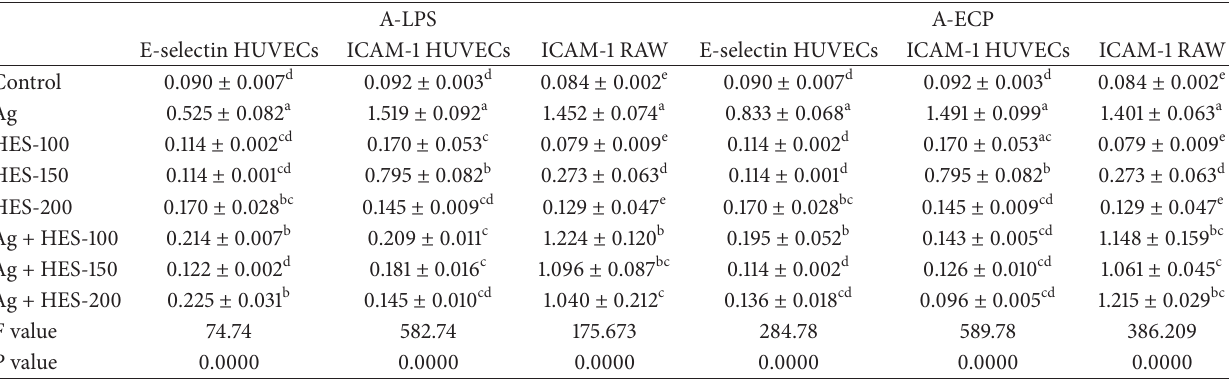
Table 1: In vitro effect of different concentrations of hesperidin on the expression of E-selectin and ICAM-1 on HUVECs and RAW cells in response to Aeromonas hydrophila antigen stimulation. Human umbilical vein endothelial cells (HUVECs) and RAW macrophage were incubated for 2 h with 100, 150, and 200 𝜇 M/mL hesperidin in the presence or absence of Aeromonas hydrophila antigen (Ag), lipopolysaccharides (A-LPS, 100ng/mL), and extracellular proteins (A-ECP, 100 ng/mL). Expression of E-selectin on HUVECs and intercellular adhesion molecule 1 (ICAM-1) on HUVECs and RAW macrophage were estimated by using modified cell ELISA. Data reported as mean optical density (OD) ± standard deviation (SD). Values of the same parameter not sharing common superscripts denote significant